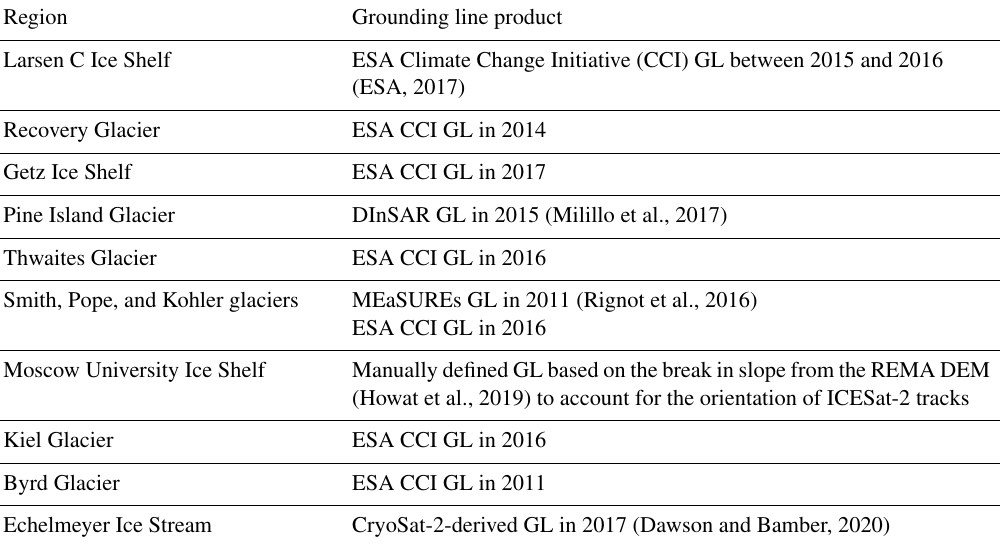
Table A1. List of different grounding line (GL) products used to update the Depoorter et al. (2013) grounding line for the composite grounding line generated in Sect.